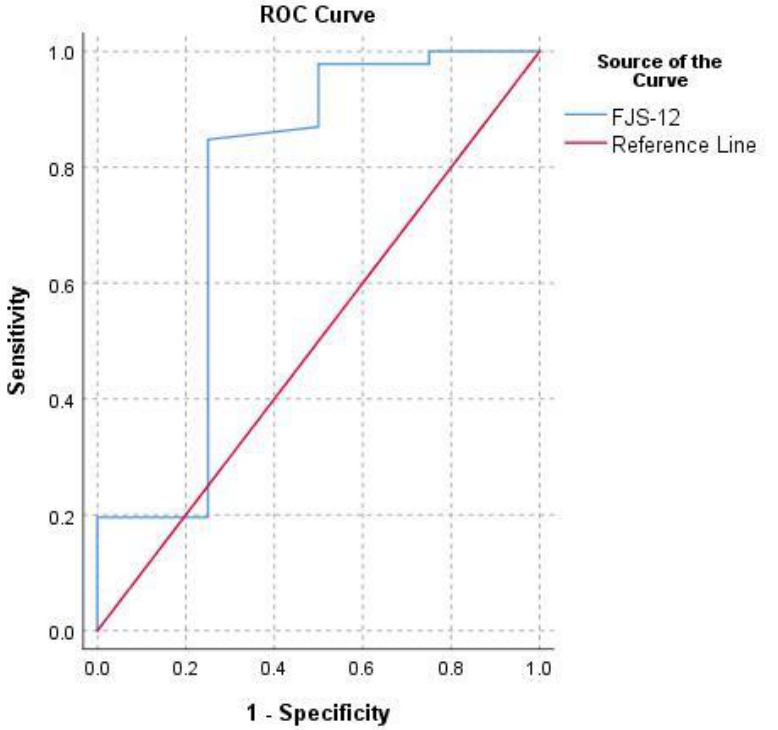
Figure 3. Receiver operating characteristic curve (ROC) for predicting FJS-12’s MCID based on the value of Oxford Hip Score (OHS) ≥ 40 at last follow-up.